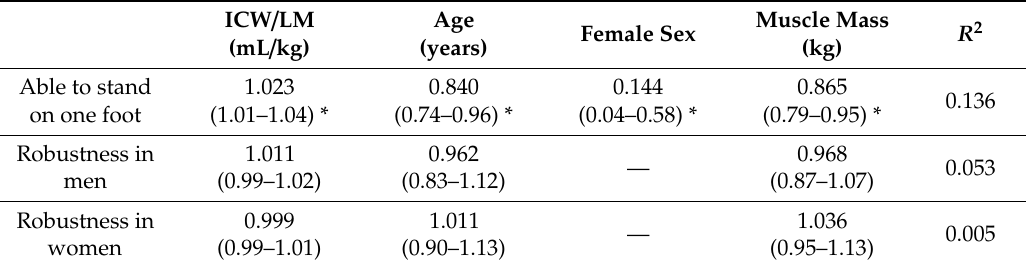
Table 4. E ff ect of the intracellular water / lean mass (ICW / LM) ratio on balance and robustness adjusted for age, sex and muscle mass (multivariate logistic regression analyses).